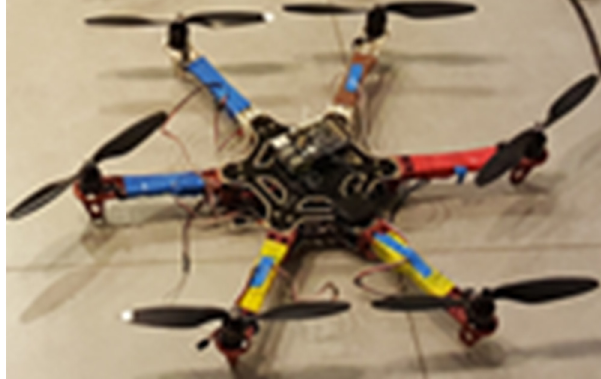
Figure 2. Unmanned aerial vehicle (UAV) model HEXA-01-UTM (Hexacopter Robot 01 from Titu Maiorescu University).